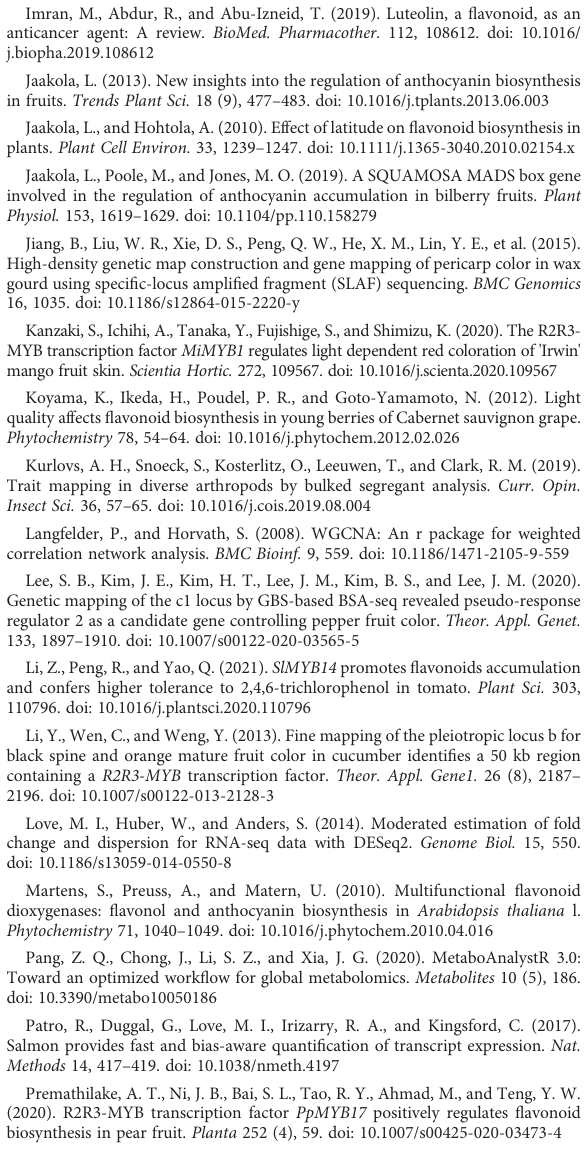
SUPPLEMENTARY FIGURE 2 The expression heatmap of BhiPRR6 (red color) and all highly co- expressed genes by RNA-seq analysis. All samples were collected at 40 DAP peels of wax